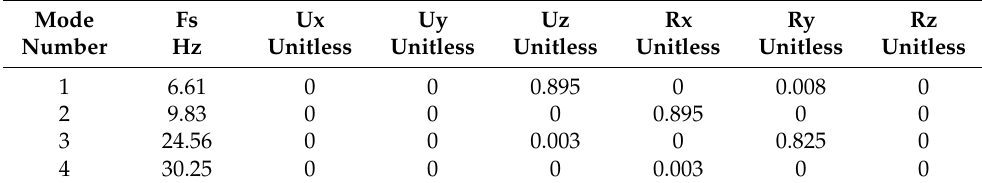
Table 5. Modal mass participation of the bridge under study.